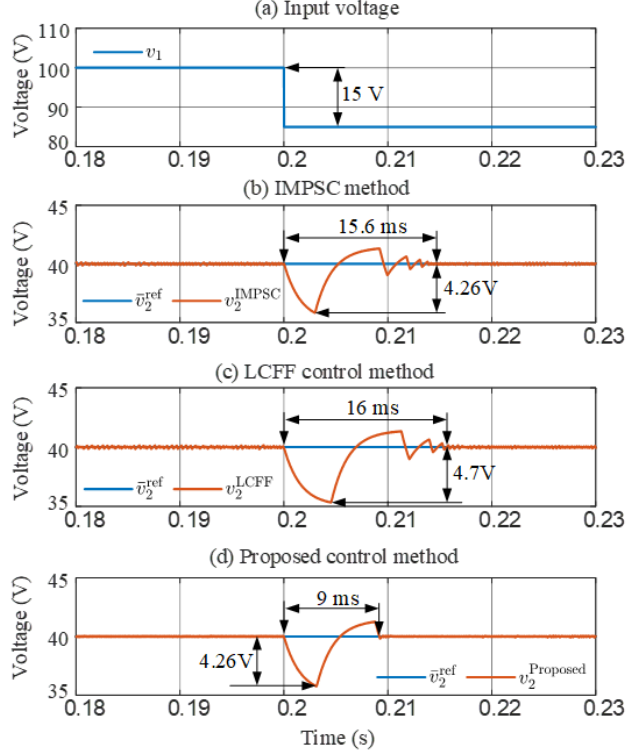
Figure 9. Simulation results of the output voltage when the input voltage steps down from 100 V to 85